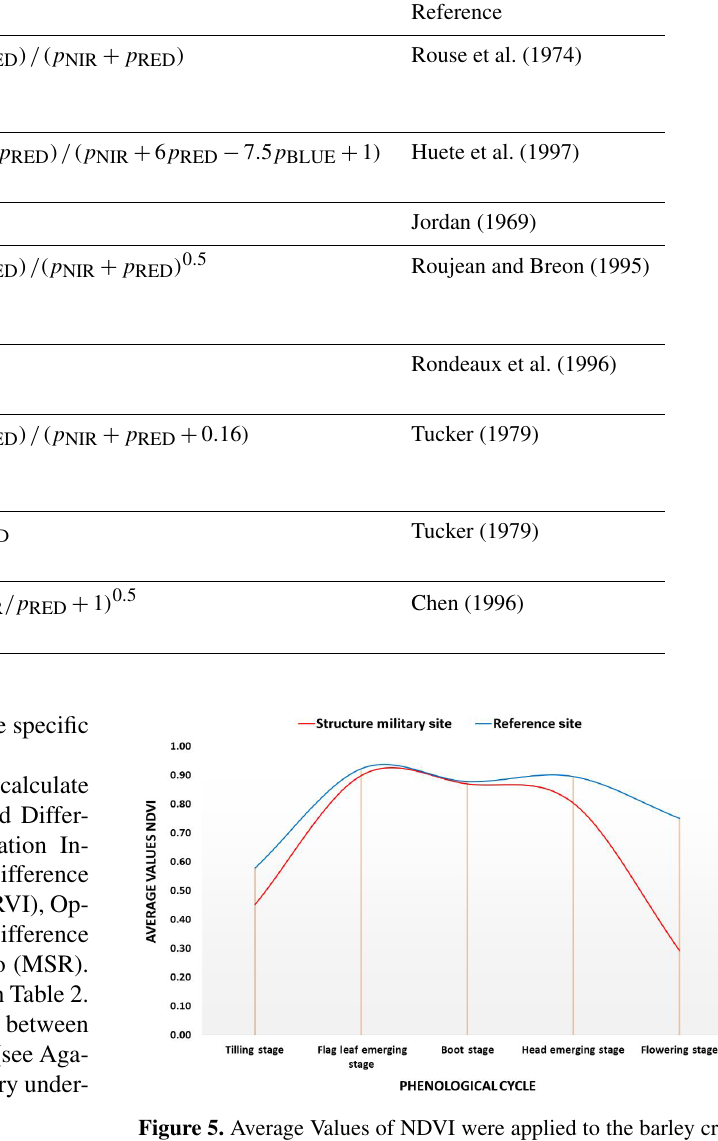
Figure 5. Average Values of NDVI were applied to the barley crop Structure Military Site (SMS) and Reference Site (RS) during the phenological